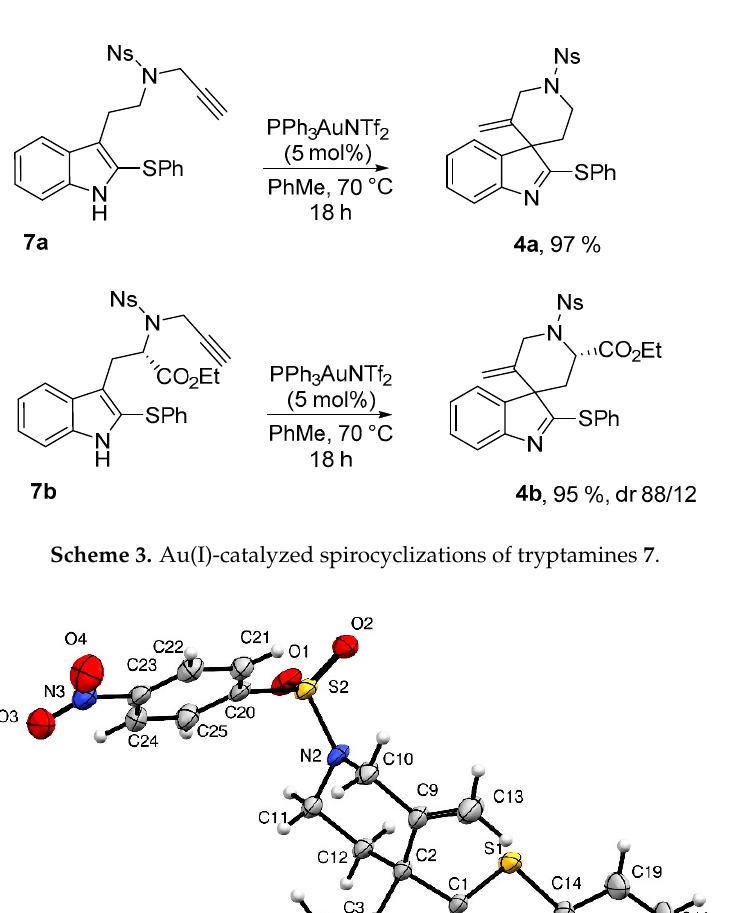
Figure 1. Structure of compound 4a (thermal ellipsoids set at 50% probability).